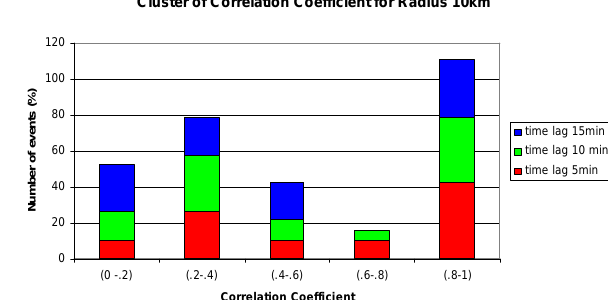
Fig. 6. The percentage of the events per time lag and for a radius of 10km.